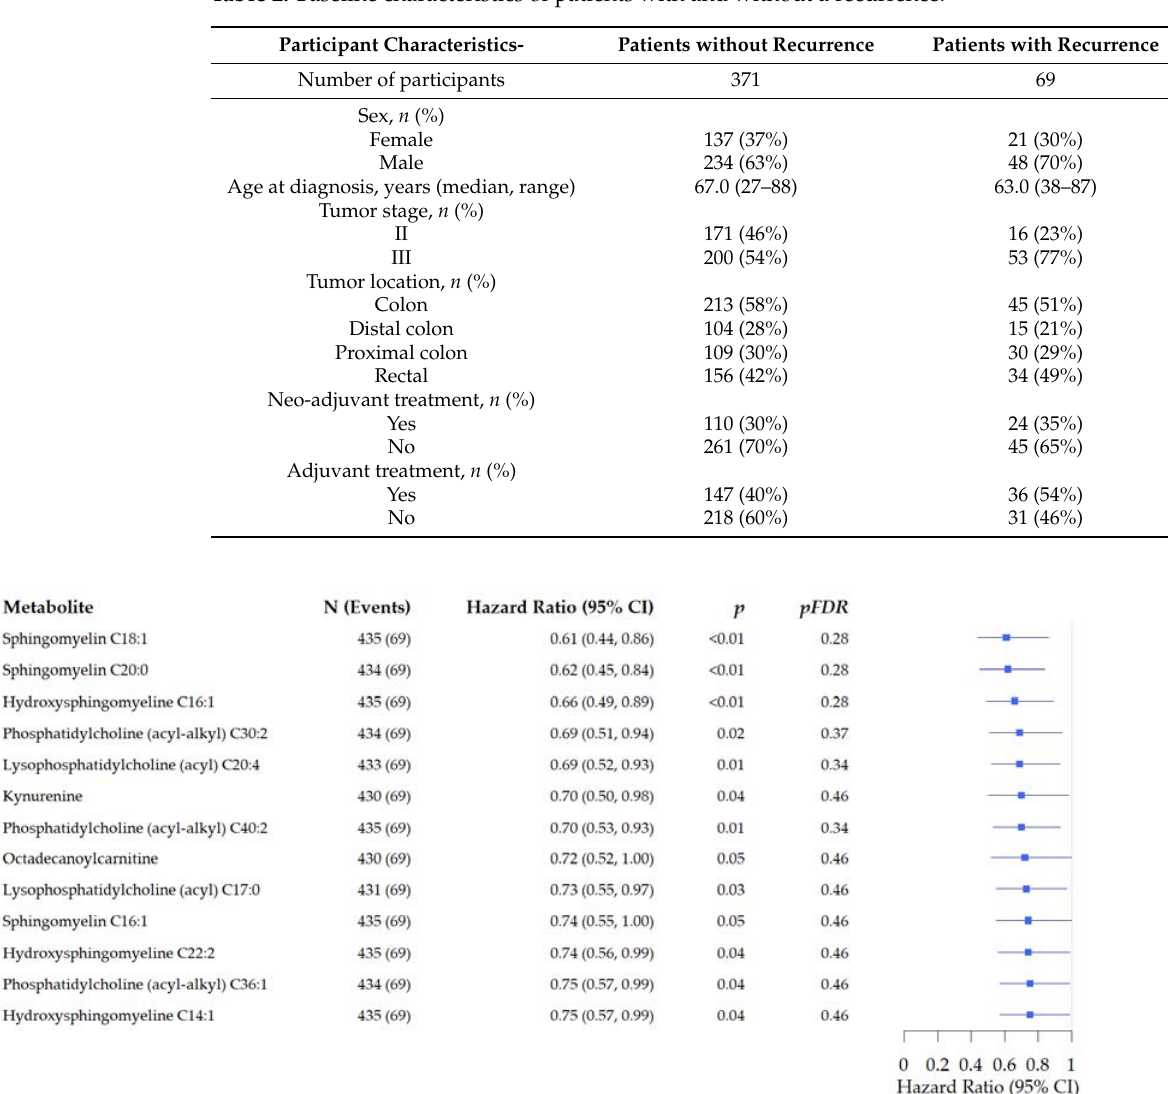
Table 2. Baseline characteristics of patients with and without a recurrence.